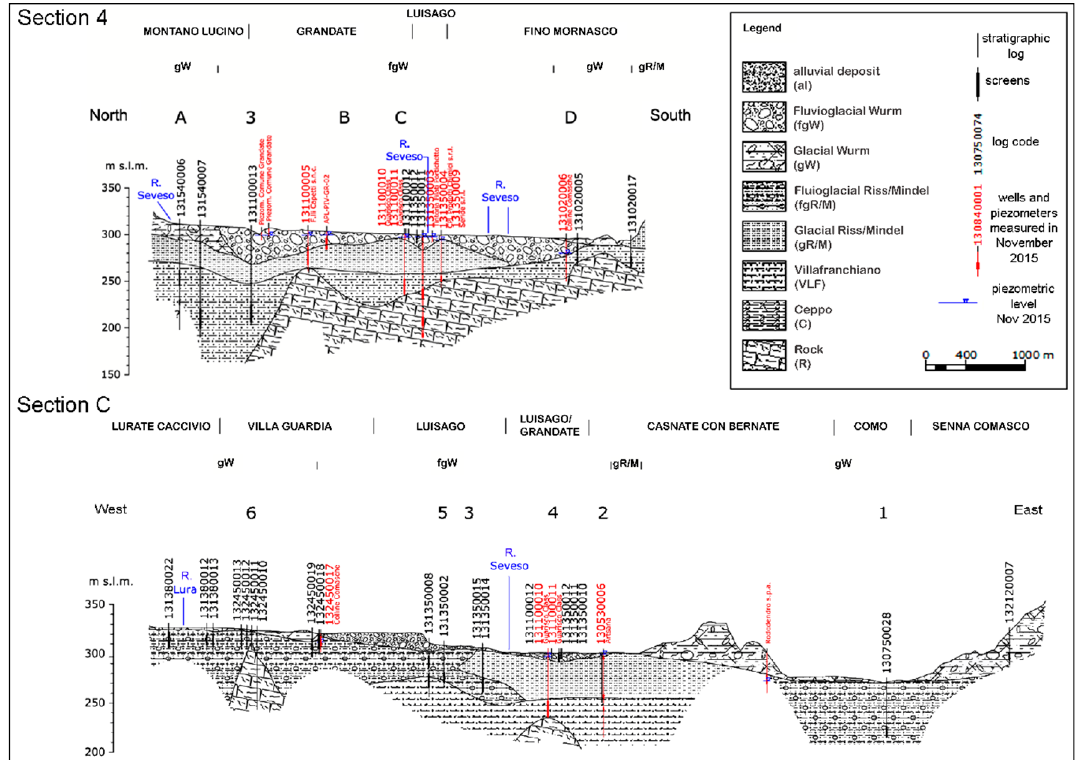
Figure 3. Cross Section 4 and C passing through the Grandate plain.